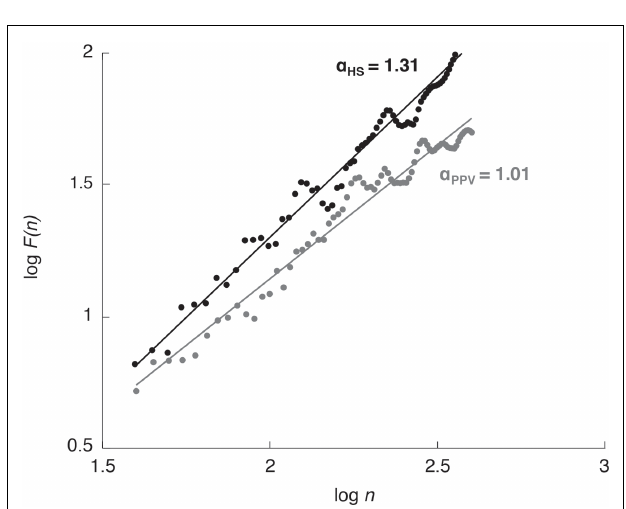
FIGURE 2 | Detrended fluctuation analysis plot for one healthy subject (HS; black dots and line) and one patient with phobic postural vertigo (PPV; gray dots and line) while standing with eyes open .The scaling exponent α quantifies the strength of long-range correlations within the CoP time